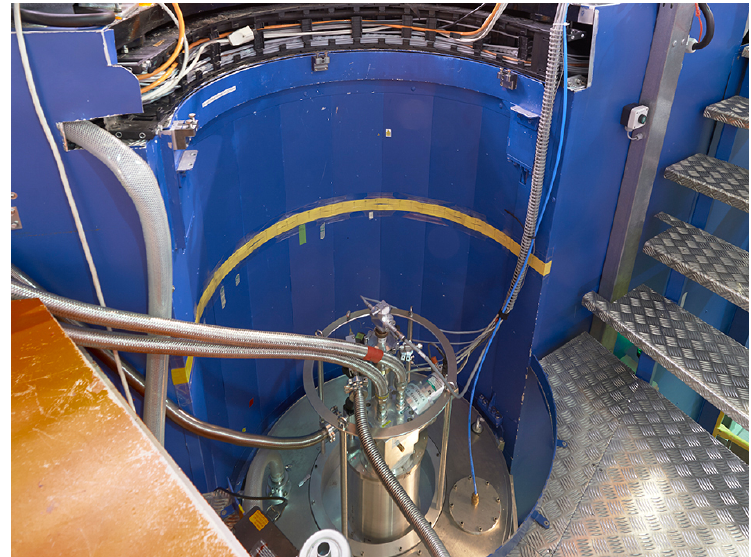
Figure 1: Top view of the CCR Cryostat inserted into the TOFTOF sample chamber. The blue panelling visible is the exterior of the detector housing (Copyright by W. Schürmann,